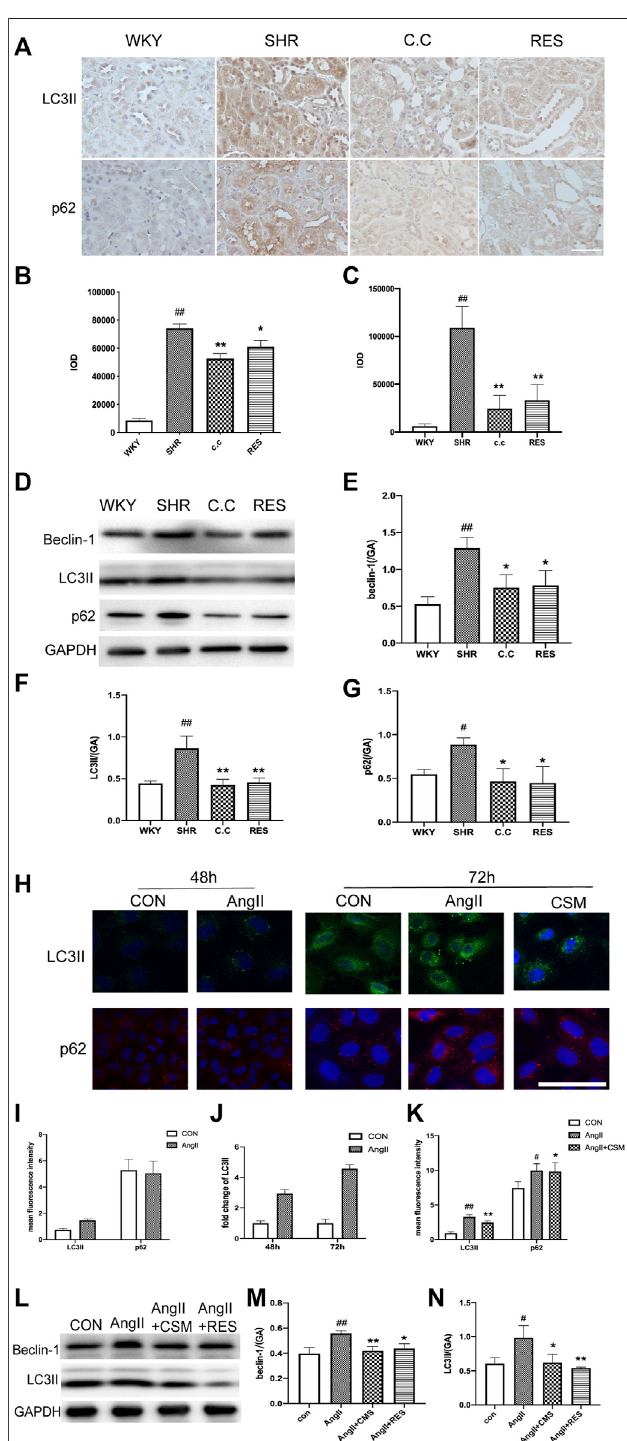
FIGURE 3 | C. cicadae and RES regulated autophagic stress in hypertensive kidney damage. (A) IHC staining result (×400) of LC3II and p62 in paraf fi n sections. Bar = 50 μ m. (B , C) Statistical results of IHC staining of LC3II andp62,respectively.Thevalueofmeanopticaldensity(IOD)obtainedby IPP software. (D) Expression of beclin-1, LC3II, and p62. The results of evaluation are shown in (E – G) . # p < 0.05, ## p < 0.01: compared with controls.